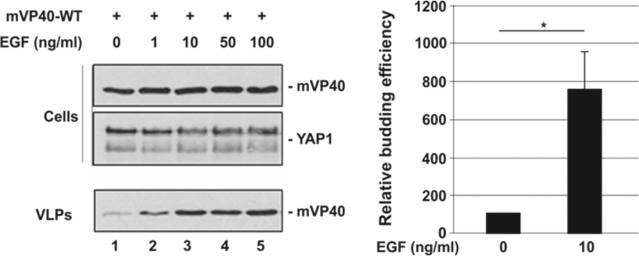
Activation of the Endogenous Hippo pathway impacts mVP40 VLP budding.U2OS cells were transfected with mVP40-WT (2μg) for 24 hrs, and then stimulated for an additional 24 hrs with the indicated concentration of purified EGF. The indicated proteins were detected and quantified in cells and VLPs by Western blotting and NIH Image-J, respectively. The bar graph represents data from three independent experiments of cells stimulated with either 0 or 10 ng/ml of EGF. The relative budding efficiency of mVP40 peaked at 10ng/ml of EGF with an average increase of approximately 7.5-fold vs. control. * p = 0.03 as determined by Welch’s t-test.